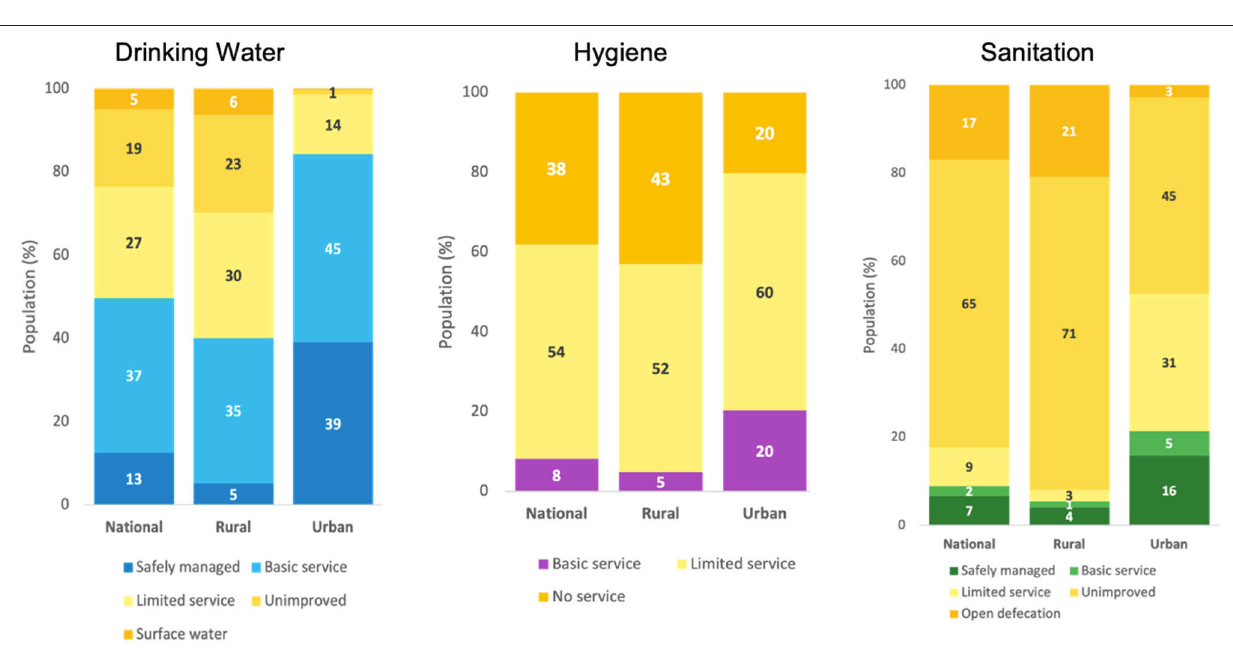
Frontiers in Human Dynamics |